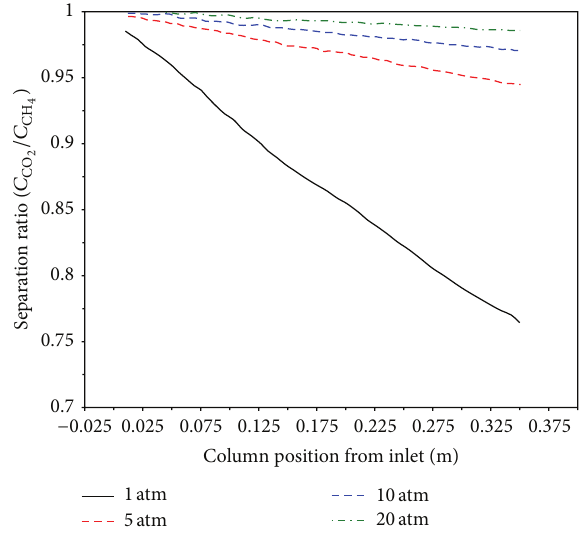
Figure 4: Pressure effects on separation ratio (flow velocity = 0.15 m/sec and temperature = 200 K).